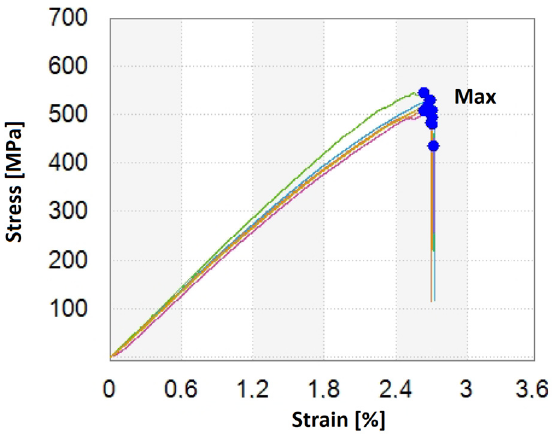
Figure 11. Stress-strain curves for S1